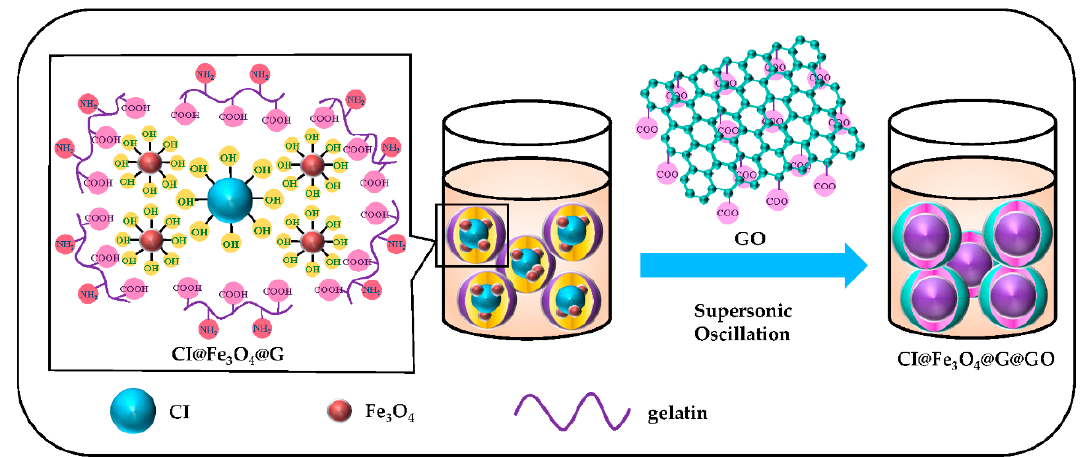
Figure 1. Schematic diagram of the preparation process for CI@Fe 3 O 4 @G@GO magnetic particles.